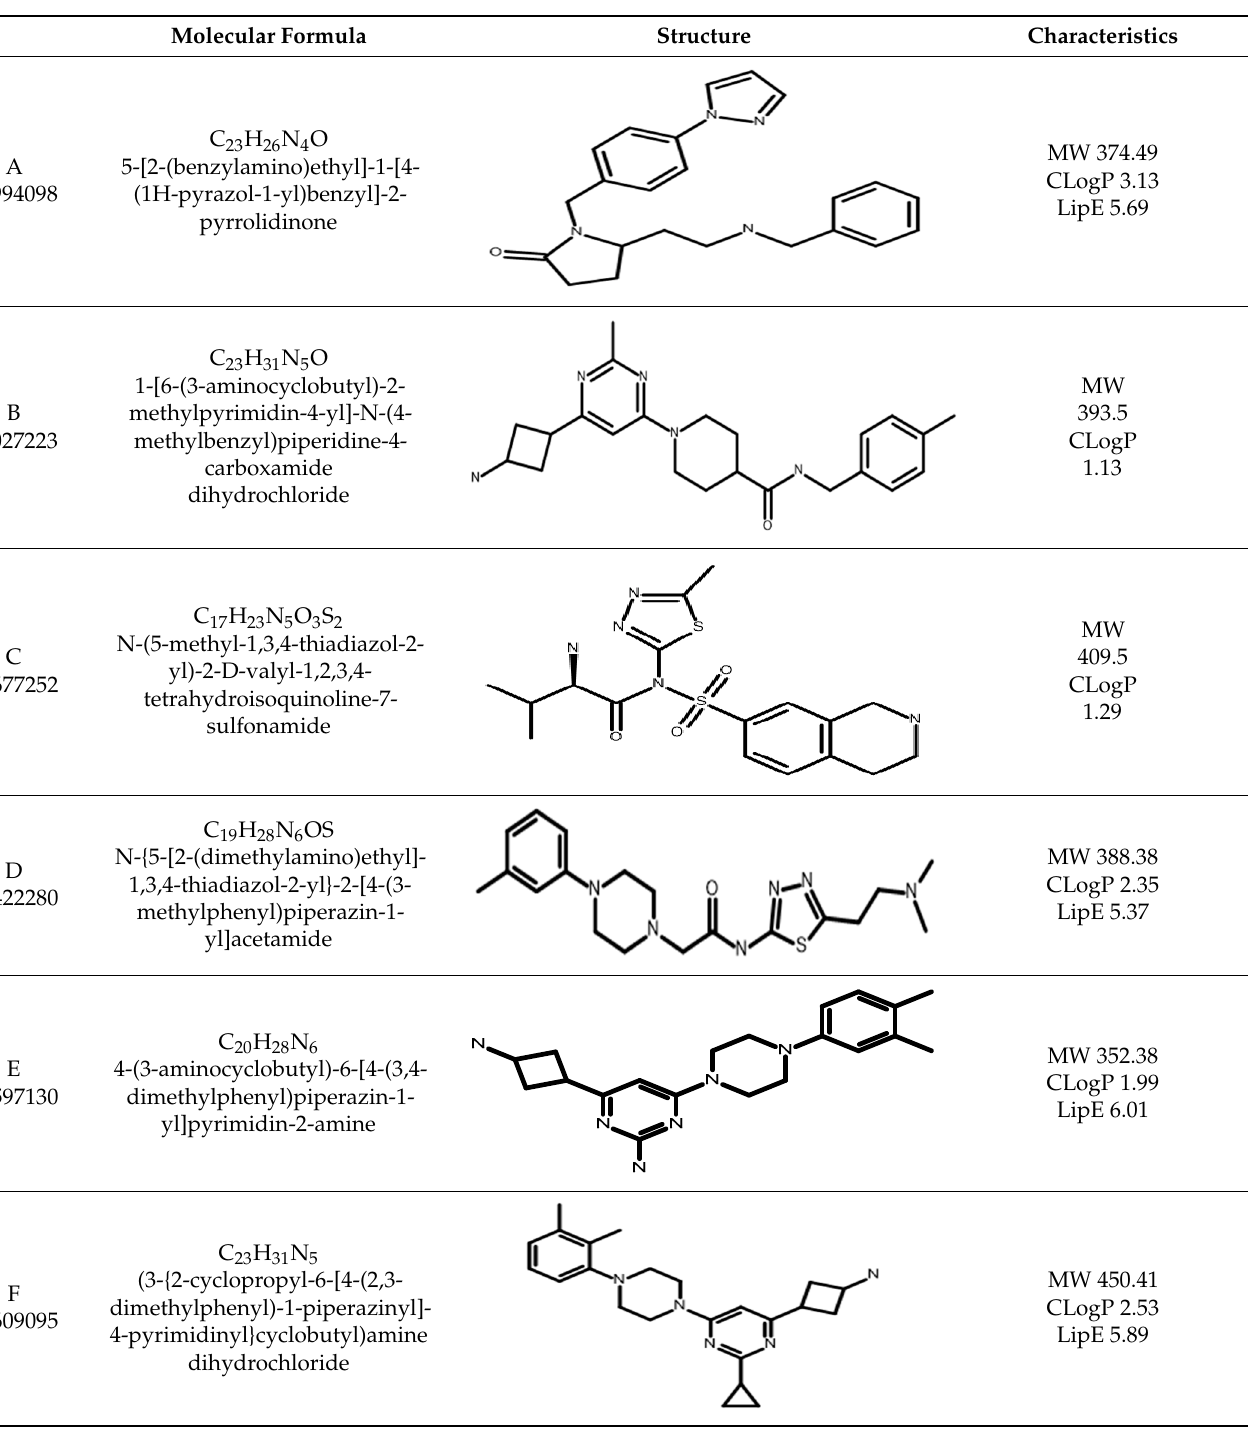
Table 2. Test inhibitors A, B, C, D, E, and F including ChemBridge Corporation identification number [23], molecular formula, structure and molecular weight (MW), lipophilicity (LipE), and partition coefficient (CLogP).